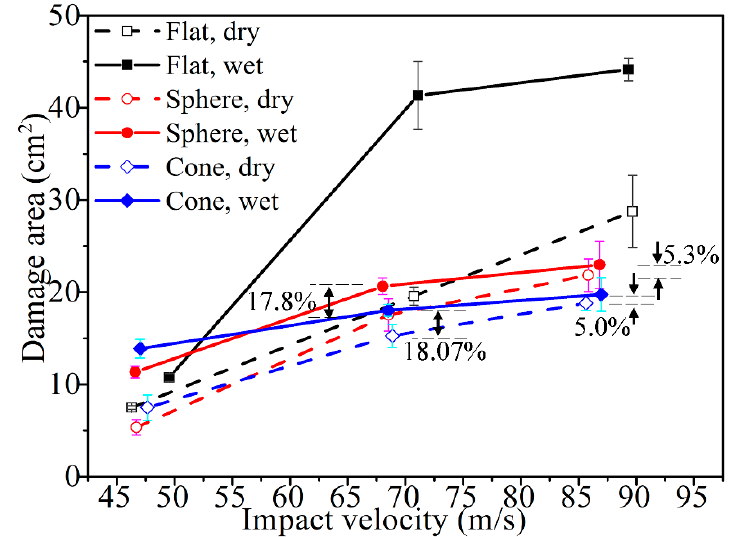
Figure 12. Projected damaged areas of the CFRP laminates in ‘‘dry’’ and ‘‘wet’’.